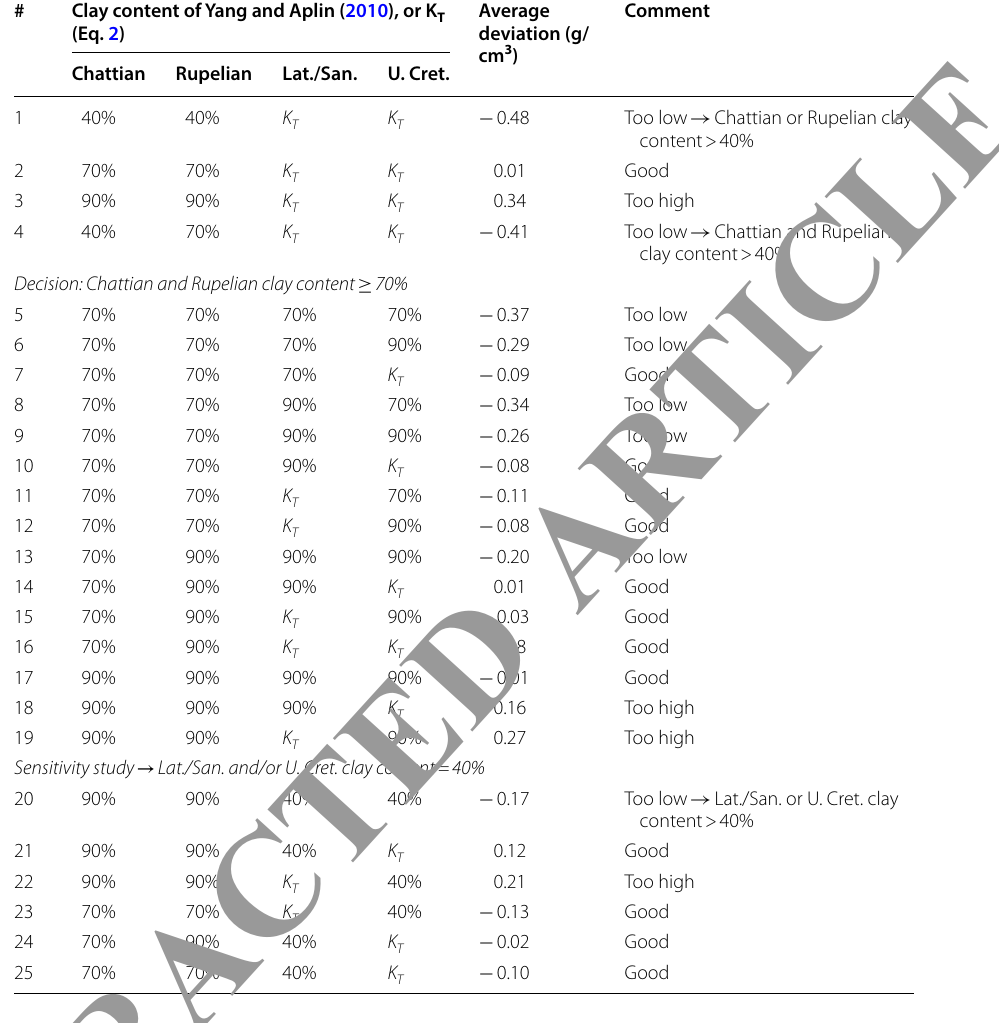
Table 4 Pore pressure calibration table and modeling rationale # Clay content of Yang and Aplin (2010), or K T (Eq. 2) Chattian Rupelian Lat./San.